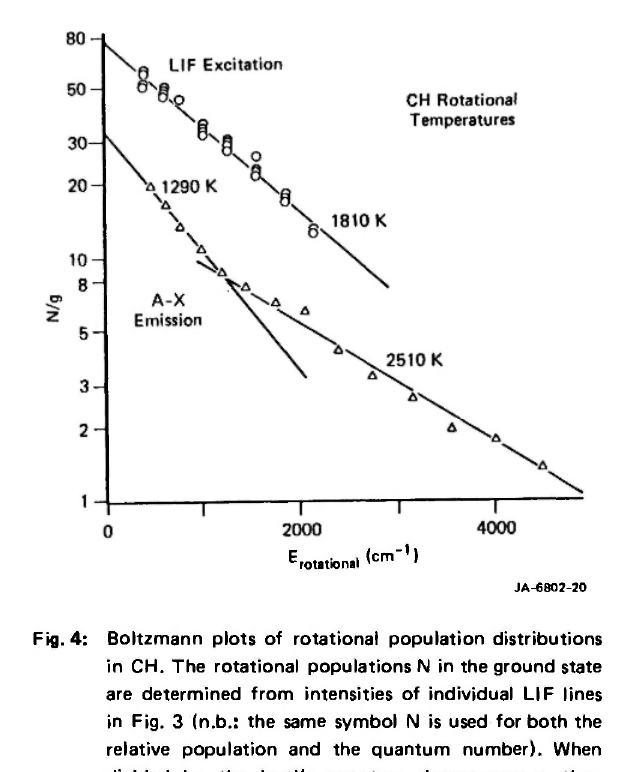
Fig. 4: Boltzmann plots of rotational population distributions in CH. The rotational populations Ν in the ground state are determined from intensities of individual LIF lines in Fig. 3 (n.b.: the same symbol Ν is used for both the relative population and the quantum number). When divided by the level's quantum degeneraacy g, they should obey the relationship N/g = exp[-E/kT] where Ε is the energy of the level and k is Boltzmann's